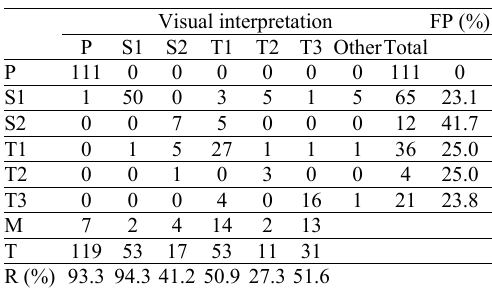
Table 2. The evaluation of road furniture interpretation in Dataset A